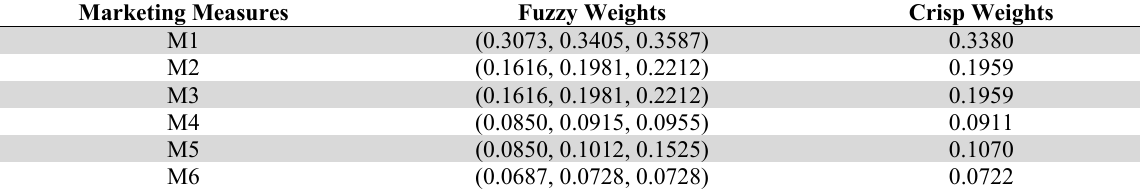
Fuzzy and Crisp Weights of Measures According to FBWM Marketing Measures